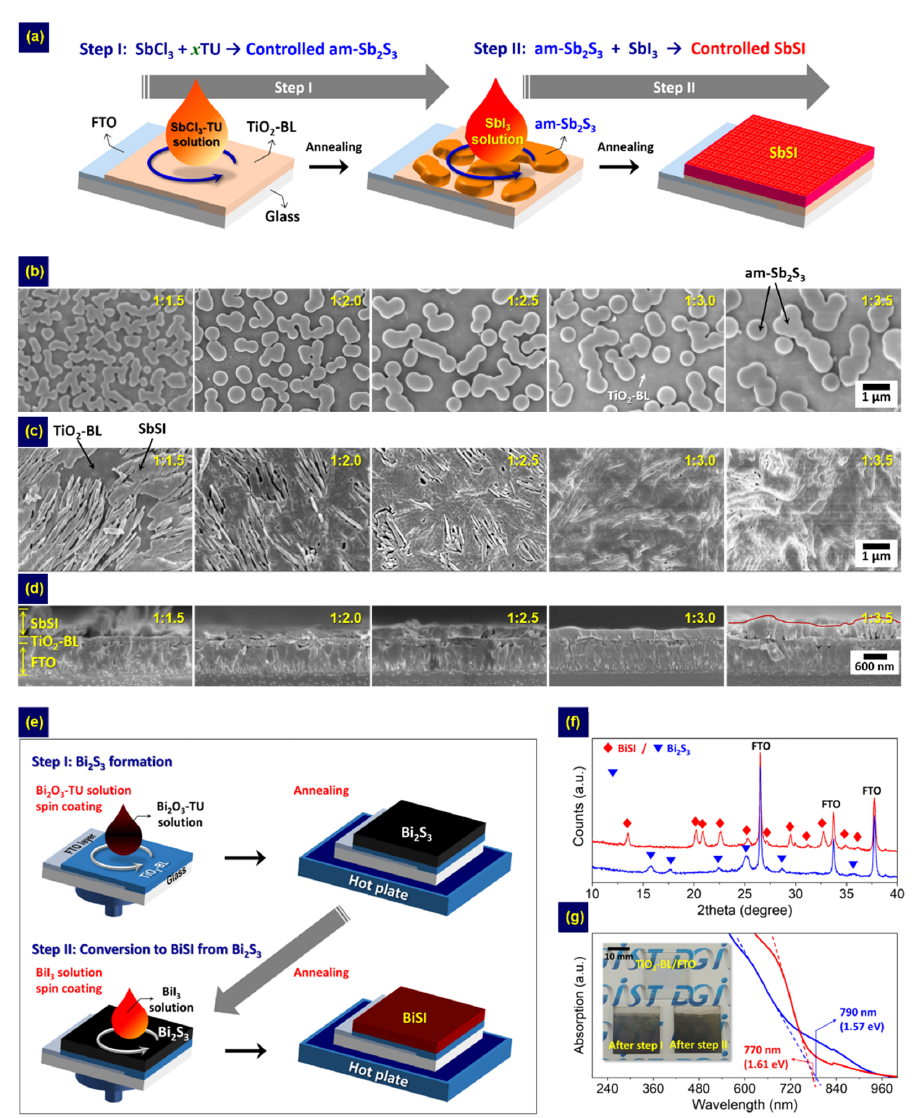
Figure 5. ( a ) Schematic illustration of the two-step method for the SbSI fabrication. Effects of Sb:S ratio on the morphology after: ( b ) step 1; ( c , d ) step 2. Adapted under the terms and conditions of the CC Schematic diagram of the two-step method for BiSI fabrication. Diagrams showing the ( f ) structure